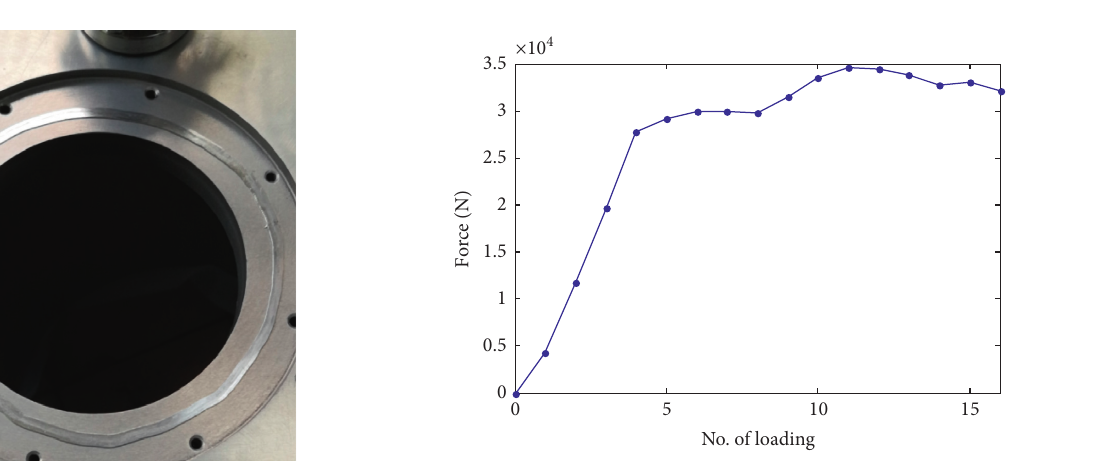
Figure 5: Values in the breaking test.